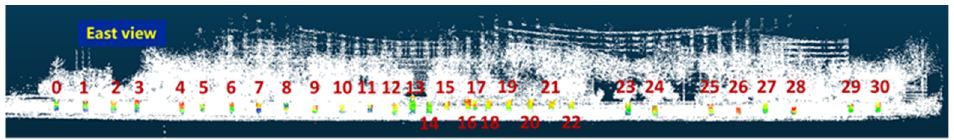
Figure 8. Target detection in map numbered 0–30, including tree trunks and lampposts, derived from the east view.